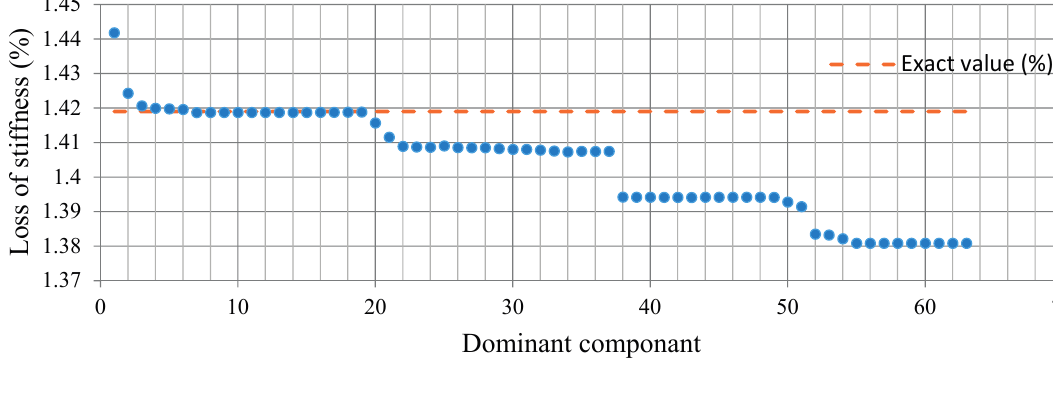
Figure 11. Loss of stiffness identification in Case 2.